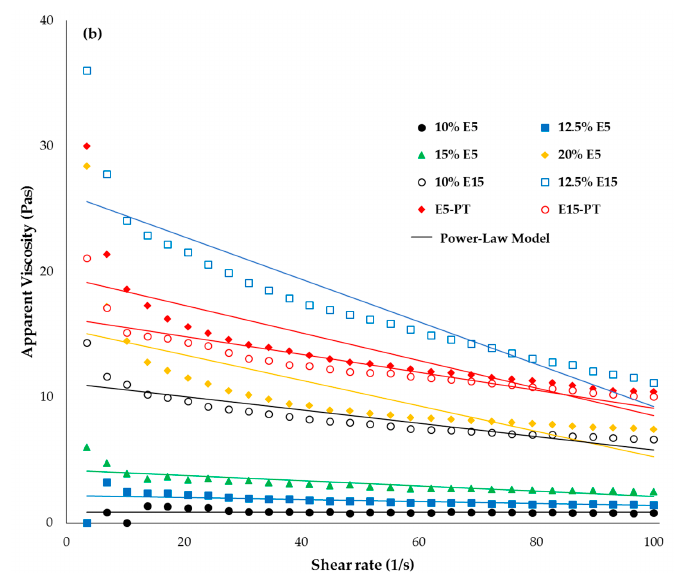
Figure 3. Rheological behaviors of hydroxypropyl methylcellulose (HPMC) E5 and HPMC E15 at different concentrations: ( a ) stress versus shear rate; ( b ) viscosity versus shear rate and fitting power ‐ law model.